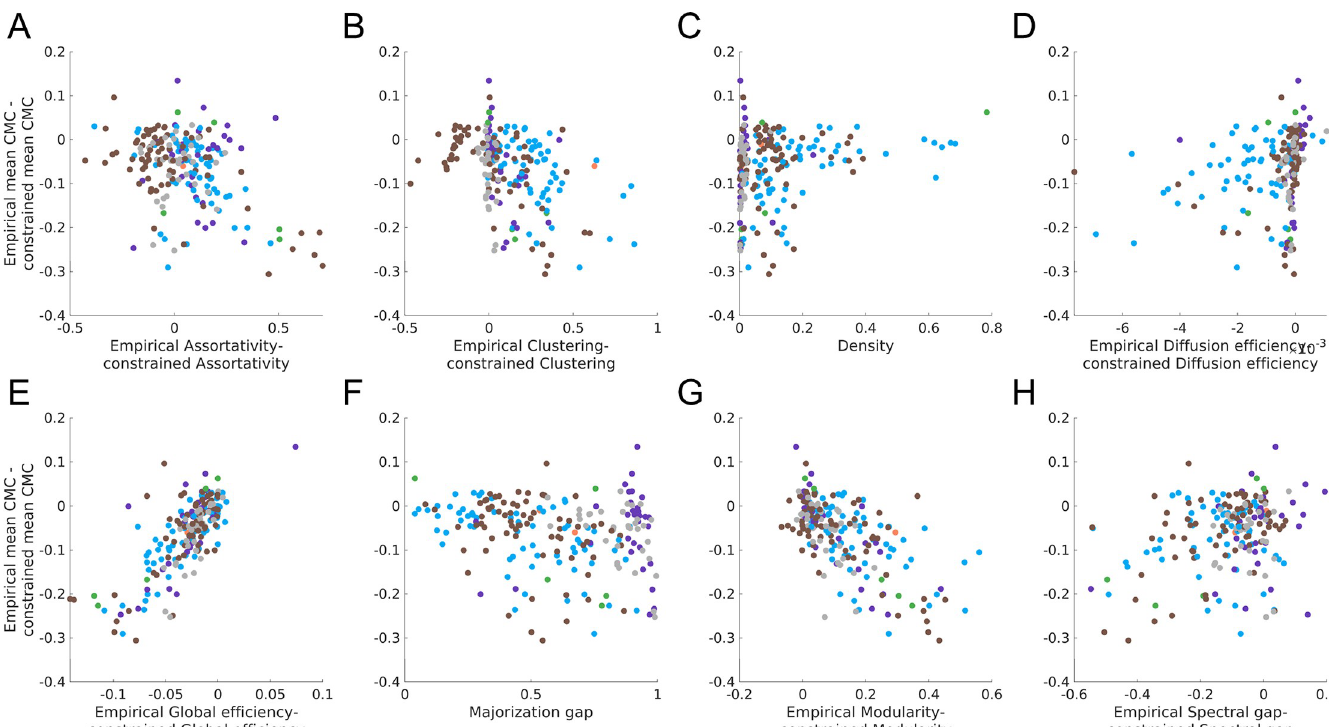
Fig 6. Difference between unweighted empirical and constrained surrogates in mean within-network CMC and network properties. The y-axis of each plot shows the difference between the empirical networks and constrained surrogates mean within-network CMC. The x-axis shows the difference between the empirical networks and constrained surrogates on a particular property (except for panels C and F as the constrained surrogates have the same density and majorization gap as the empirical network). On both axis, except for the x-axis in panels C and F , a negative value indicates the empirical network had a lower value than the mean value of the surrogates, while a positive value indicates the empirical networks had a larger value. Points are coloured by the natural category of the empirical network (blue = social, grey = technological, brown = biological, orange = informational, purple = transportation; green = economic).